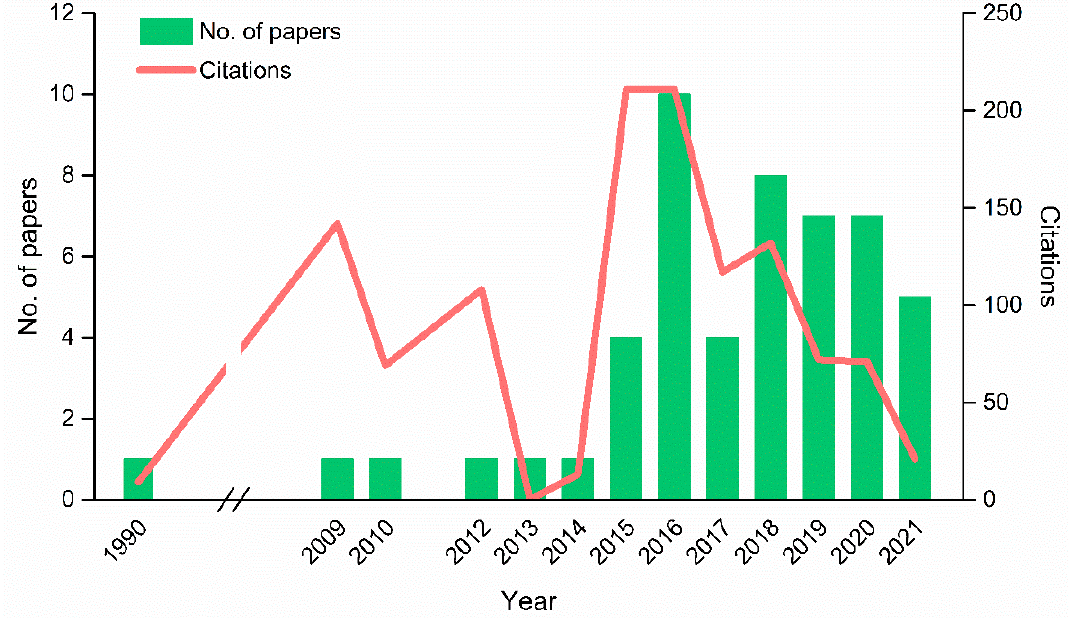
Figure 3. Number of papers related to the lichen microbiome and their citations. Data obtained using the search terms “lichen microbiome” or “lichen microbiota” or “lichen bacterial community” or “lichen microbial” or “lichen bacteria” or “lichen-associated bacteria” in the Web of Science (https://www.webofscience.com/wos/woscc/basic-search). Accessed on 13 February 2022. All results were checked to ensure that they were referred to the presence of microorganisms in the lichen symbiosis.